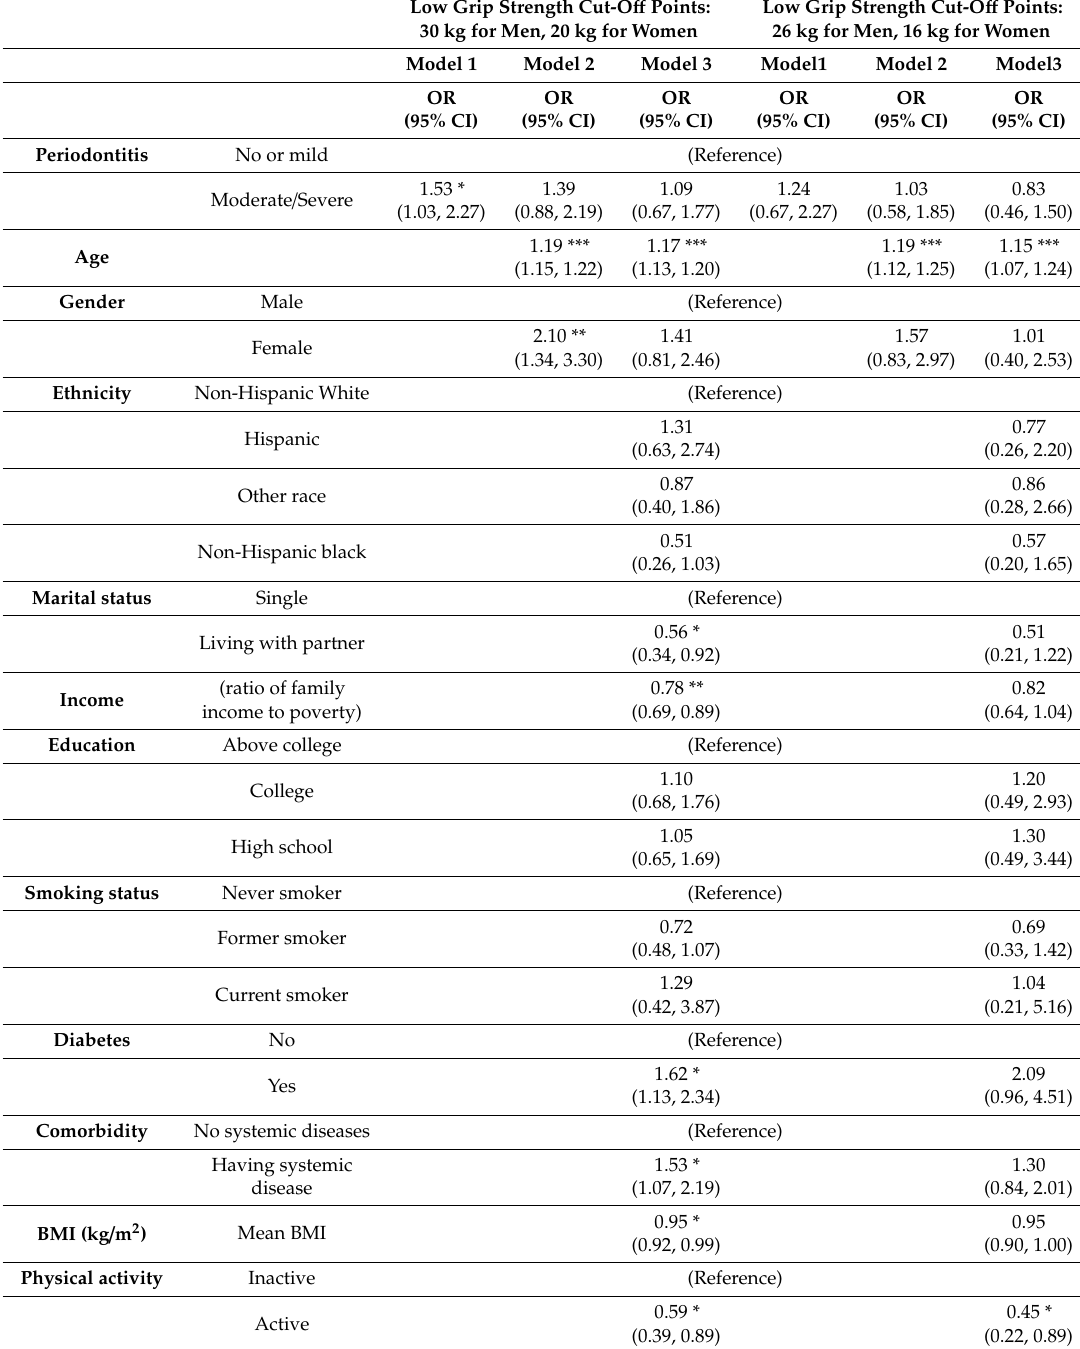
Table 2. Logistic regression models showing the associations between Periodontal disease and low grip strength among the study sample (N =